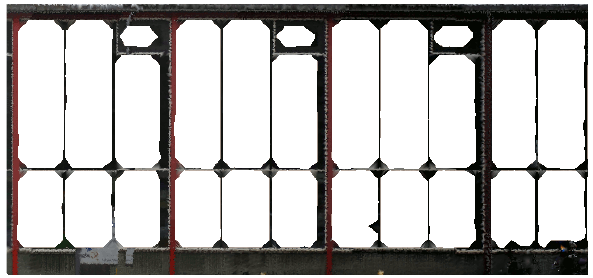
Figure 11: Building facade containing holes caused by windows.